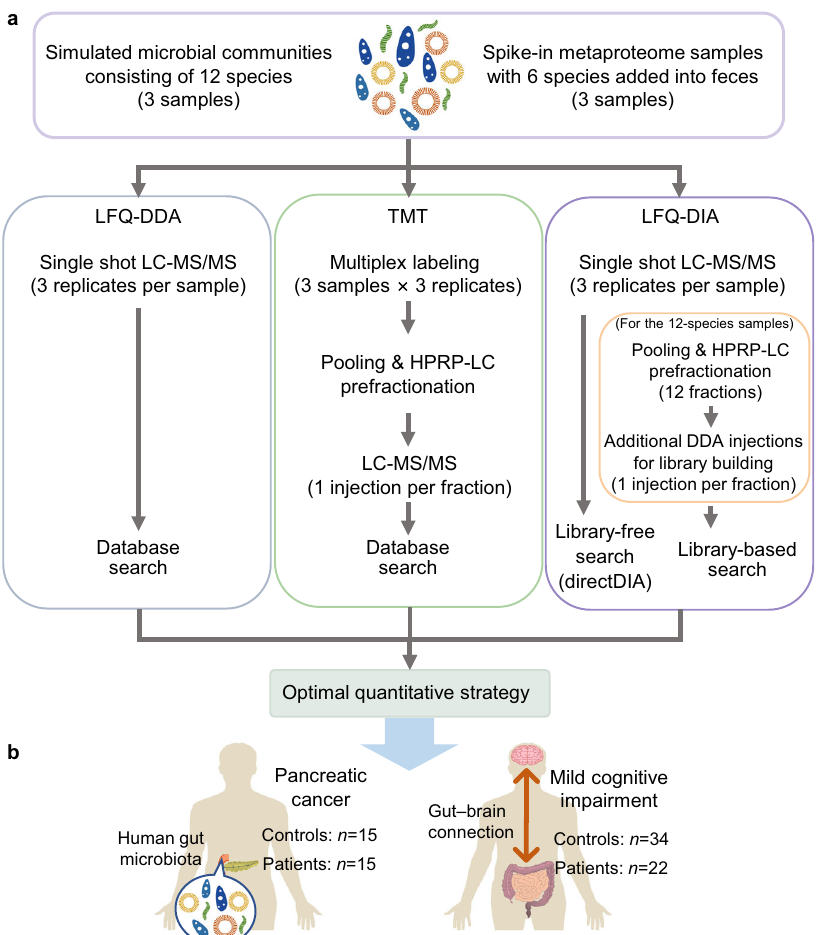
Fig. 1 Overview of the study. a Benchmarking label-free quanti fi cation by data-dependent acquisition (LFQ-DDA) and data-independent acquisition (LFQ-DIA), as well as isobaric tandem mass tag (TMT)-based quanti fi cation, on simulated microbial communities consisting of 12 species of bacteria and feces samples spiked with 6 species. b Pro fi ling human gut metaproteome in clinical samples of pancreatic cancer patients and mild cognitive impairment